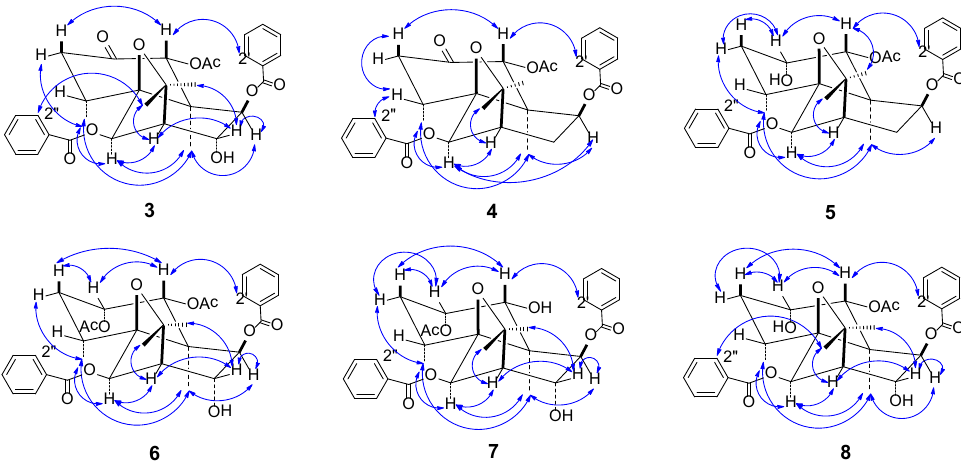
Figure 4. Main NOE correlation signals ( ←→ ) in the NOESY spectra of 3 – 8